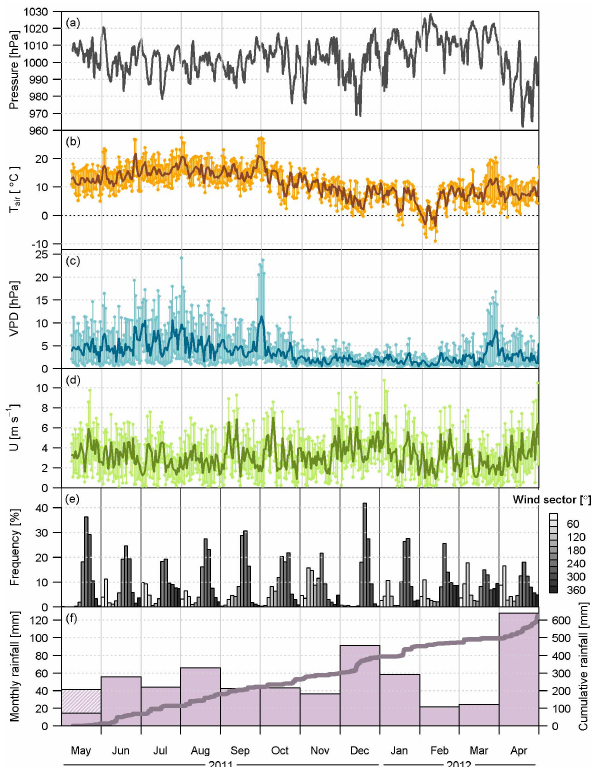
Fig. 3. Meteorological conditions during the study period: (a) mean station pressure; daily mean, maximum and minimum (b) air temperature; (c) vapour pressure deficit (VPD); (d) wind speed; (e) frequency distribution of 30min wind direction by month; (f) cumulative and monthly rainfall totals. In (f) the hatched bar represents rainfall during May 2011 before the start of this dataset (measured in central Swindon (51 ◦ 34 0 0.3 00 N, 1 ◦ 47 0 5.3 00 W)).